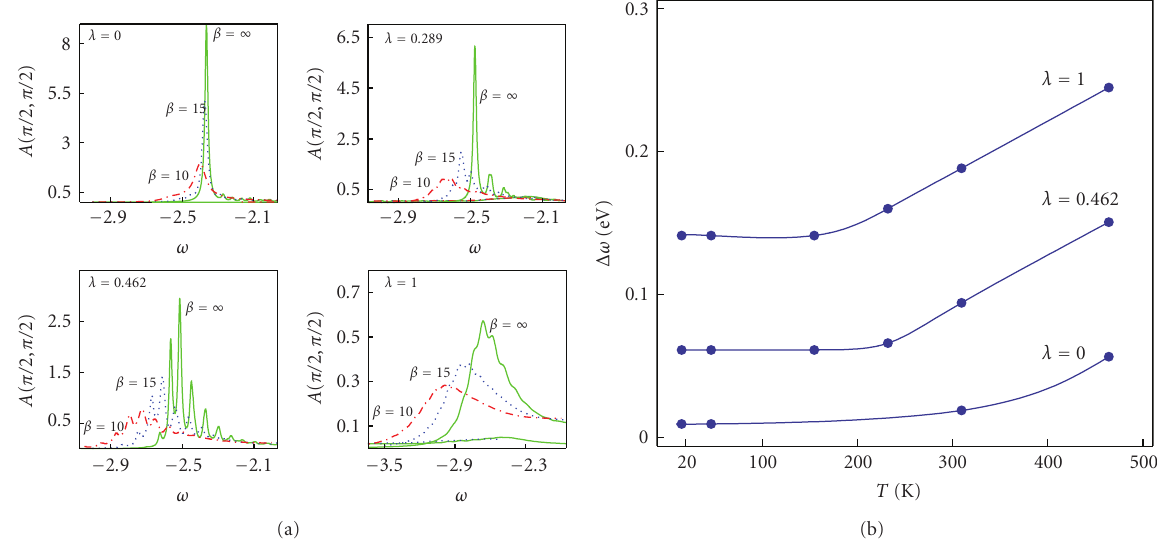
Figure 8: (a) Spectral functions for di ff erent λ and temperatures β = t/T . (b) Peak width Δ ω as a function of temperature T for the t-J model ( λ = 0) and t-J-H model in the strong coupling EPI limit ( λ = 0 . 462 and λ = 1). Temperature is in Kelvins under assumption that t = 0 .